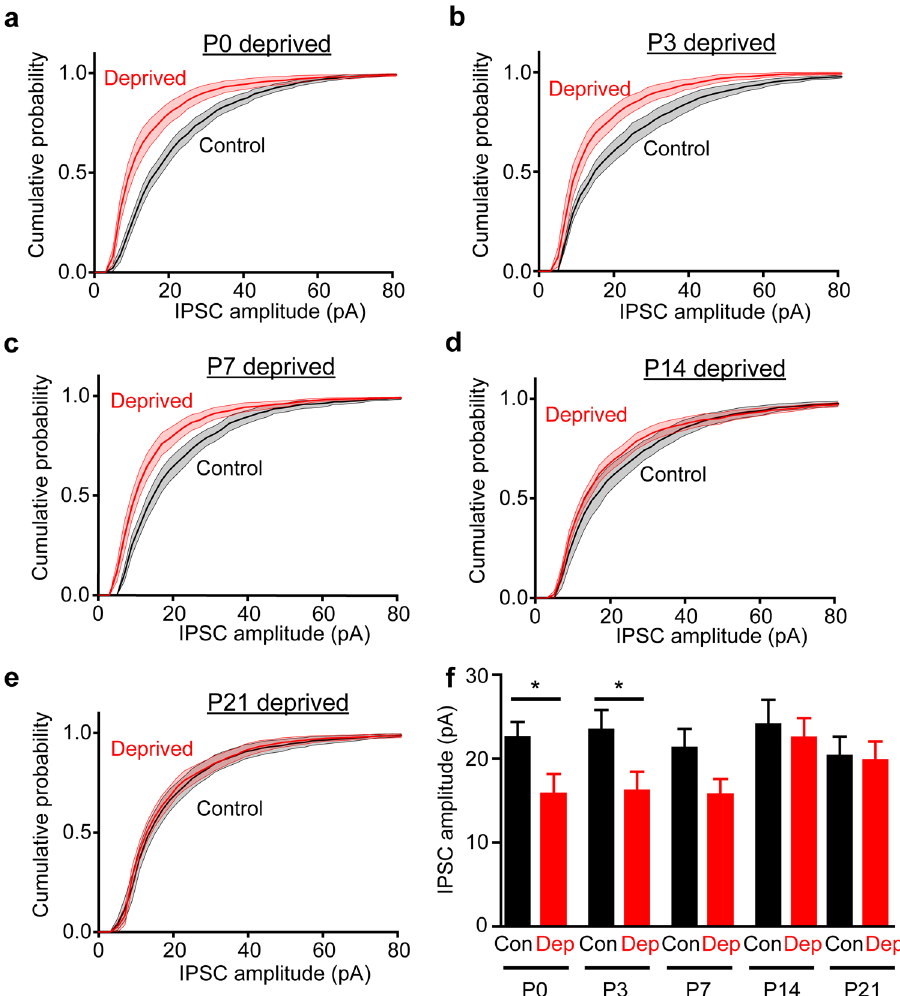
Figure 5. The sensitivity of PV interneuron-mediated IPSCs to whisker deprivation decreases with developmental age. ( a )–( e ) Averaged probability cumulative distributions of IPSCs for deprived slices converged with controls at P14 and P21 deprivation. ( f ) Mean inhibition in deprived slices was decreased significantly with deprivation starting at P0 (p = 0.016) and P3 (p = 0.032), and recovered to similar levels to controls when the deprivation date was delayed to P7, P14 and P21 (p = 0.073 at P7, 0.48 at P14, and 0.80 at P21 respectively; Mann-Whitney two-tailed test comparing only within each timepoint group independently, n numbers of P0: 14 cells each for controls and deprived, corresponding to 12 animals for controls, 11 animals for deprived, P3: 9 cells each for controls and deprived, corresponding to 6 animals each for controls and deprived, P7: 9 cells controls and 14 cells deprived, corresponding to 8 animals for controls, 12 animals for deprived, P14: 8 cells controls and 11 cells deprived, corresponding to 5 animals for control, 7 animals for deprived, P21: 12 cells each for controls and deprived, corresponding to 9 animals for control, 7 animals for deprived). Error bars represent